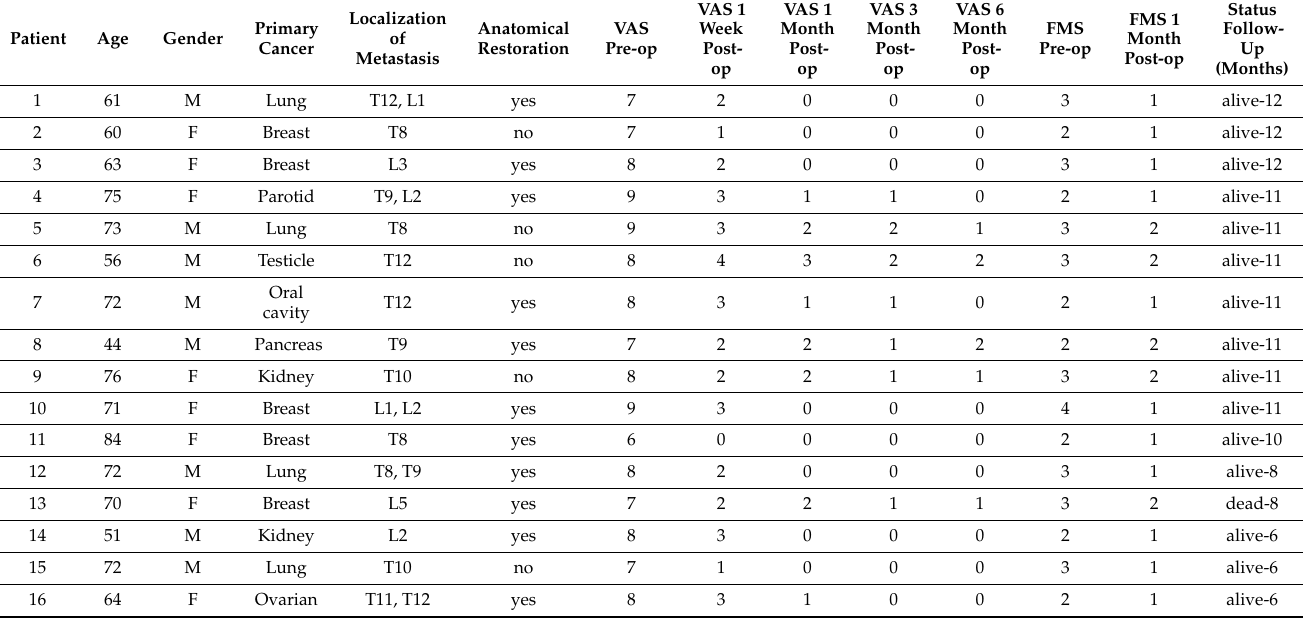
Table 1. Patient and tumor characteristics and follow-up. VAS: Visual Analogue Score.